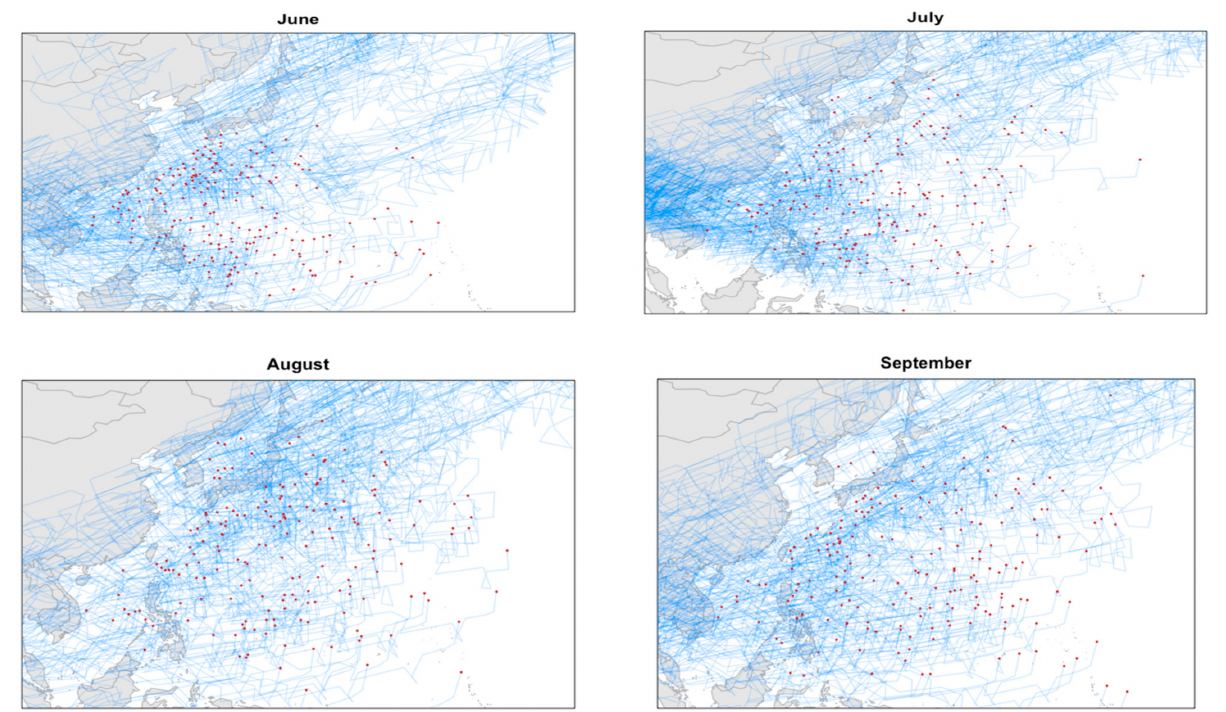
Figure 6. Modeled typhoon genesis (indicated by red dots) and tracks (indicated by blue lines) of WNP region in June–September.